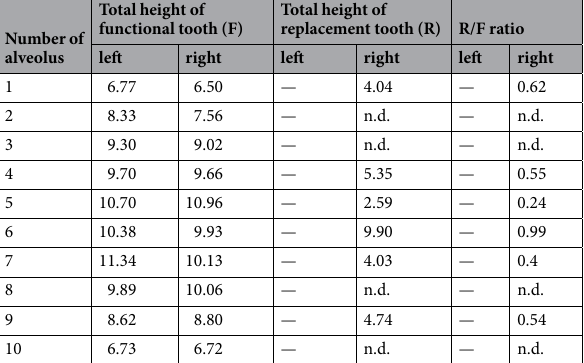
try was seen in tooth replacement patterns as well as some symmetry between patterns across the upper and lower jaws. Miller and Radnor 48 examined the skulls of 15 young Caiman sclerops and found that bilateral symmetry